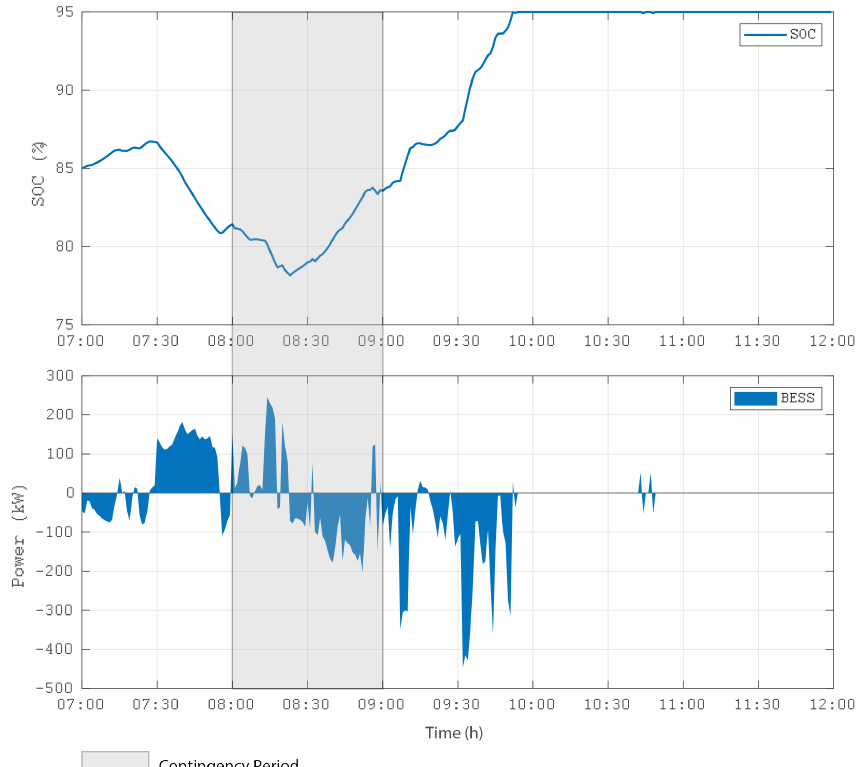
Figure 12. SOC variation and BESS injected/absorbed power for off-grid operation—case with a single DG unit